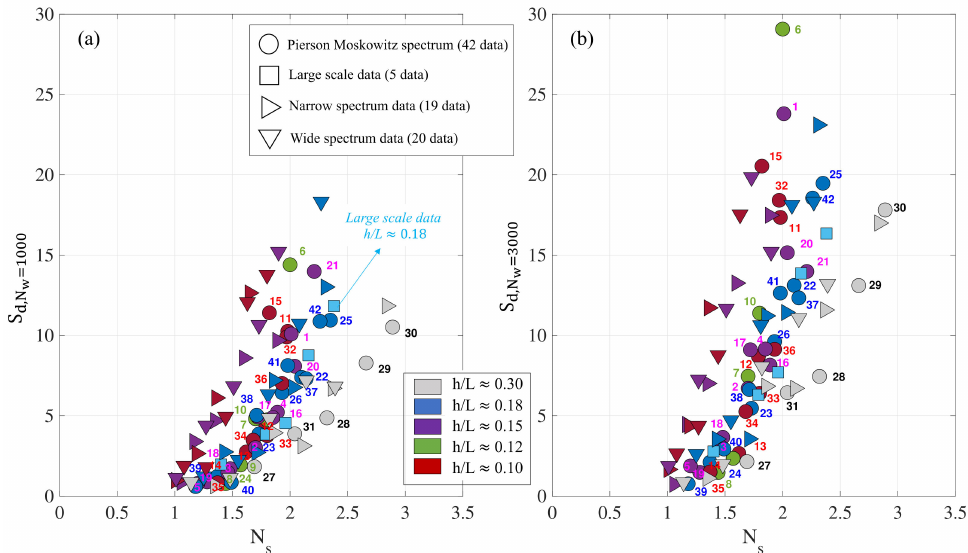
Figure 3. Progression of damage, S d , against the stability number, N s , (or wave height, H sI , or wave steepness, H sI / L ) under number of waves ( a ) N w = 1000 and ( b ) N w = 3000. By colors the values of relative water depth, h / L , at the toe of the slope is identified. The data were taken from